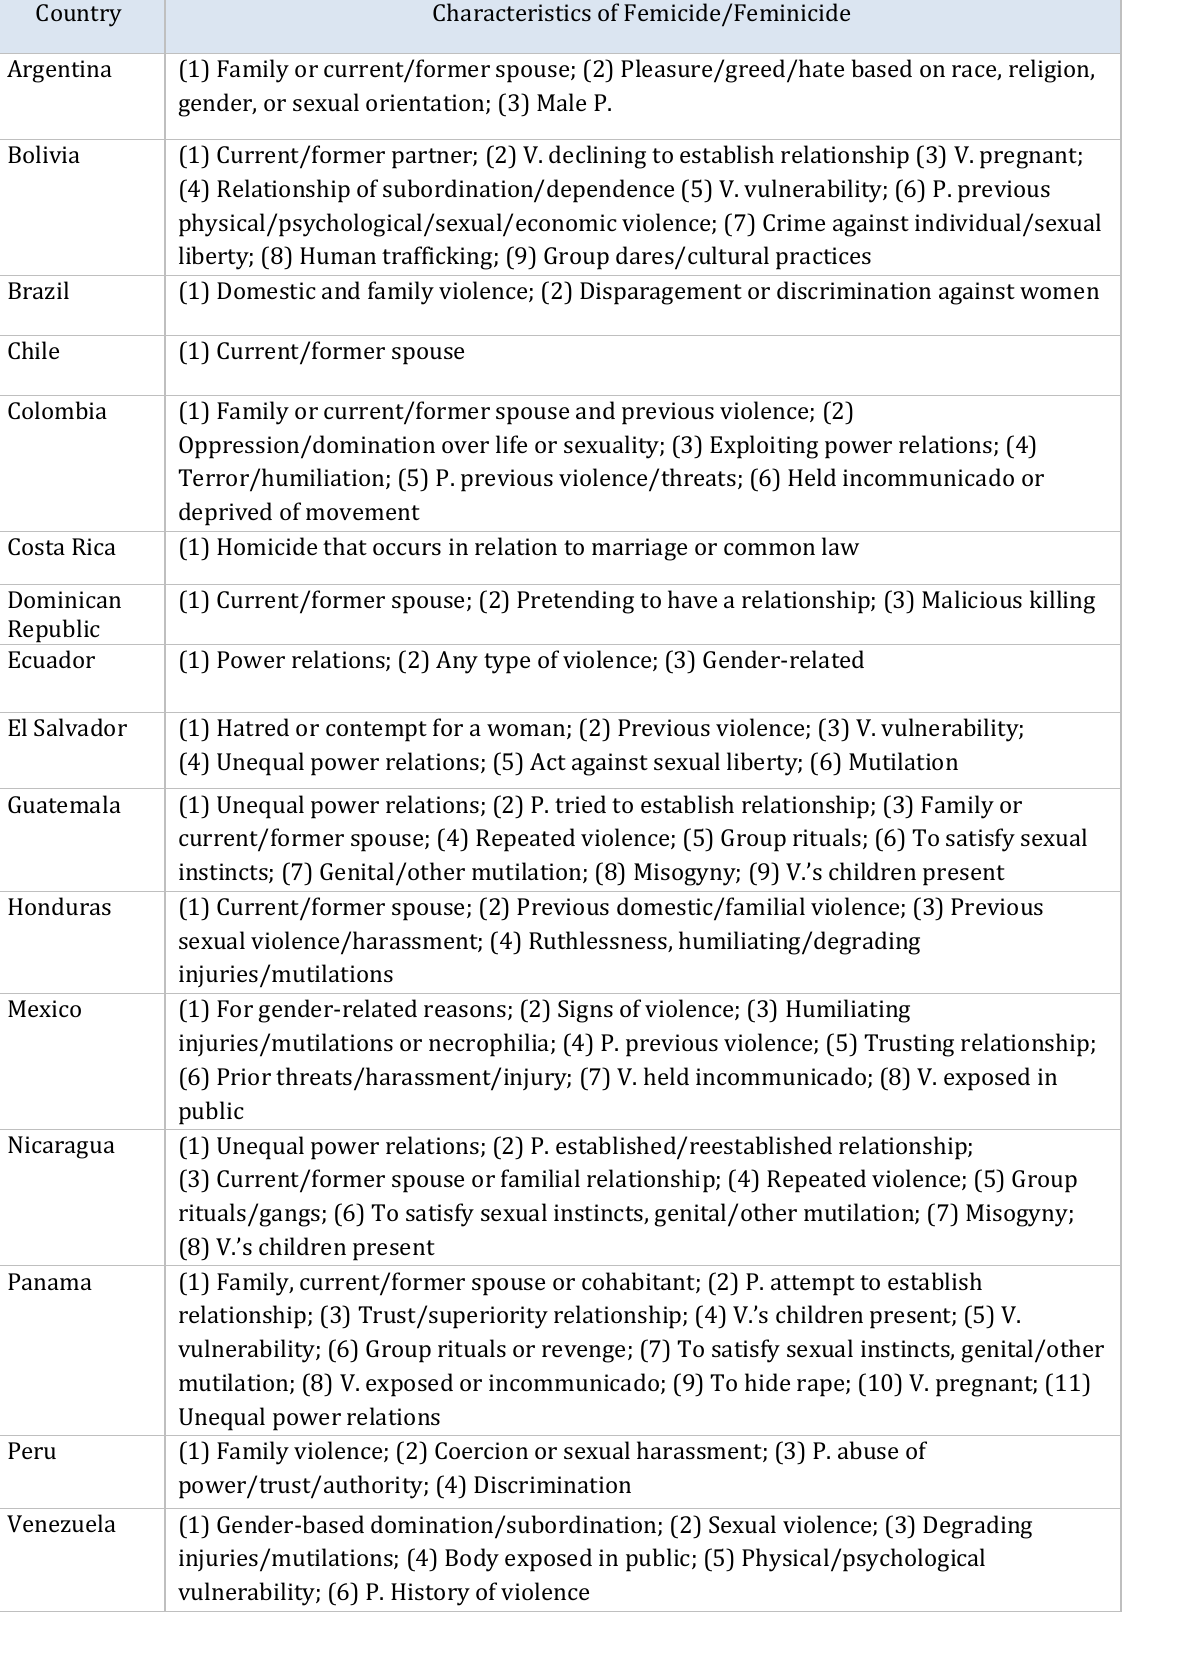
Table 2: Summary of Femicide/Feminicide Legislation in Latin America, by Country